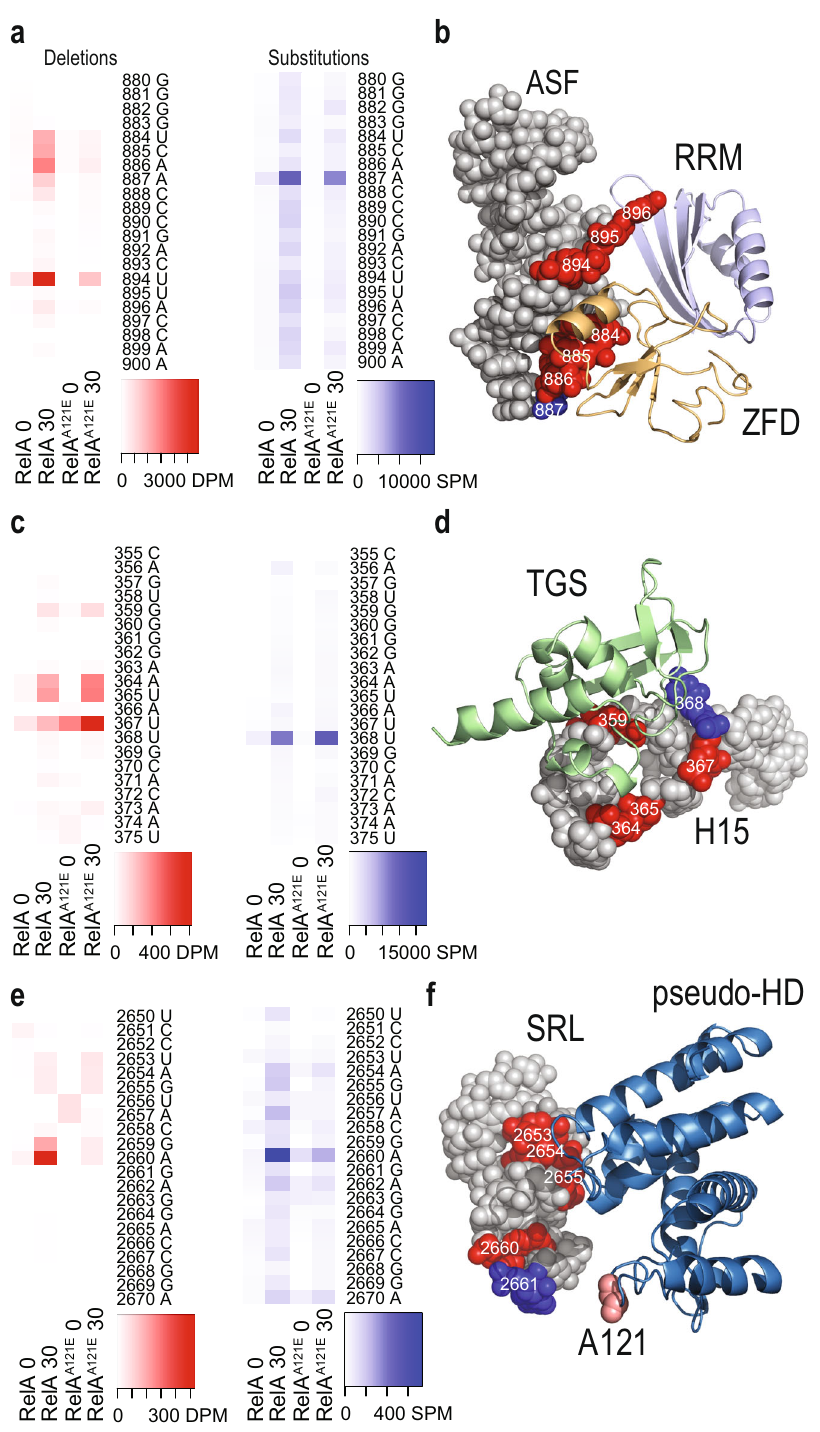
Fig. 4 RelA A121E ribosome interaction is analogous to RelA. RT-mutations (deletion and substitutions) in cDNA reads obtained with CRAC analysis of MG1655 encoding relA::HTF or relA A121E ::HTF before and 30 min after isoleucine starvation (here named 0 or 30, respectively). Heatmaps show nucleobase positions with increased error-frequencies caused by RelA (cid:129) RNA crosslinking. Deletions per million, DPM, or Substitutions per million, SPM, are indicated in red and blue respectively. a RT-mutations in the A-site fi nger (ASF) of 23 S rRNA (nt 880 – 900). b Close-up on the ASF (PDB: 5IQR) with positions with signi fi cant number of RT-mutations. Deletions or substitutions are shown in red and blue, respectively. ZFD and RRM domains of RelA are coloured in pale orange and pale blue. c RT-mutations in helix 15 (H15) of 16 S rRNA (nt 355 – 375). d Close-up on H15 (PDB: 5IQR) with crosslinking sites. TGS domain of RelA is displayed in pale green. e RT-mutations in the Sarcin-Ricin Loop (SRL) of 23 S rRNA (nt 2650 – 2670). f Close-up on SRL (PDB: 5IQR) with crosslinking sites. The pseudo-HD of RelA is shown in blue and the position of mutated alanine 121 is highlighted in salmon. RT-mutations from biological replicates see Supplementary Fig. 4a –